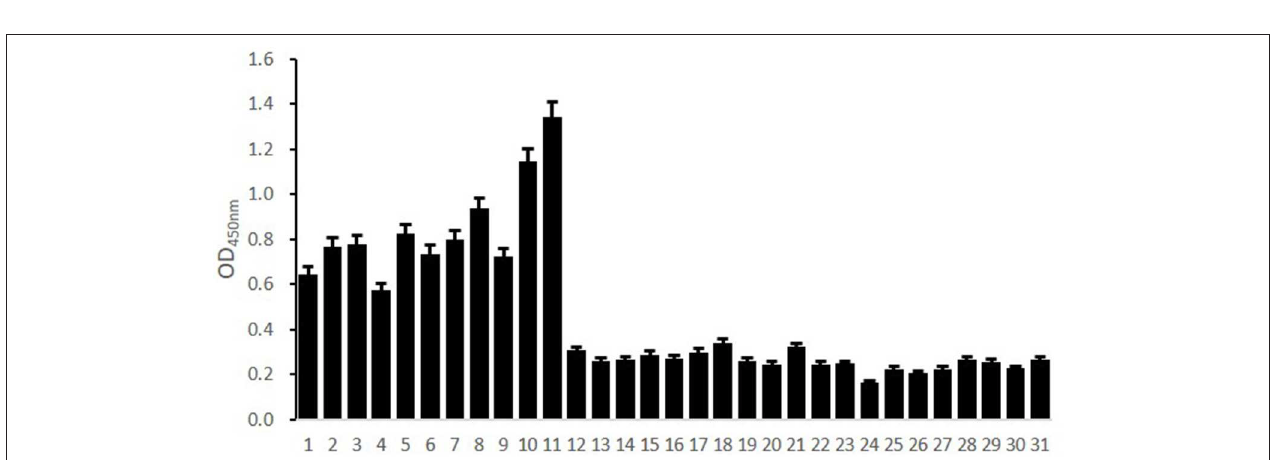
FIGURE 6 | Evaluation of the detection ability of Sao 355 − 372 by ELISA. ELISA plate was coated with Sao 355 − 372 . Then, human serum samples of known origin were detected. Columns 1–11 showed the results of reactions between Sao 355 − 372 and antibodies from patients with S. suis infection. Columns 12–27 showed the results of reactions between Sao 355 − 372 and serum from healthy people. Columns 28–31 showed the results of reactions between Sao 355 − 372 and antibodies from patients infected by Staphylococcus epidermidis , Enterococcus faecium , Klebsiella pneumoniae , and Escherichia coli . The results showed that the core epitope Sao 355 − 372 only reacted with antibodies from the 11 patients with S . suis infection. It did not react with convalescent serum of patients infected with Klebsiella pneumoniae , Escherichia coli , Staphylococcus epidermidis , or Enterococcus faecium , or with negative serum from healthy people ( P <